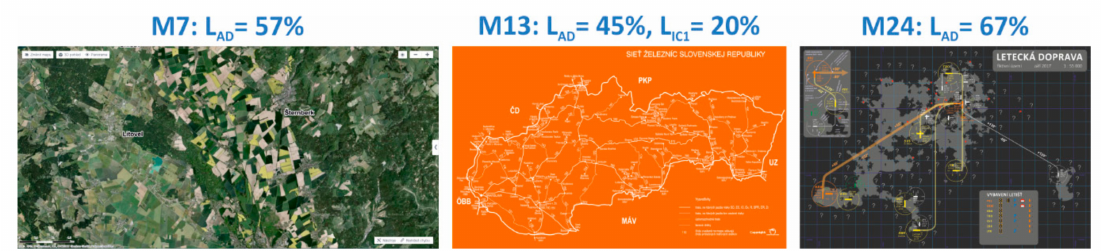
Figure 9. Examples of the maps where map load values were overestimated using AD